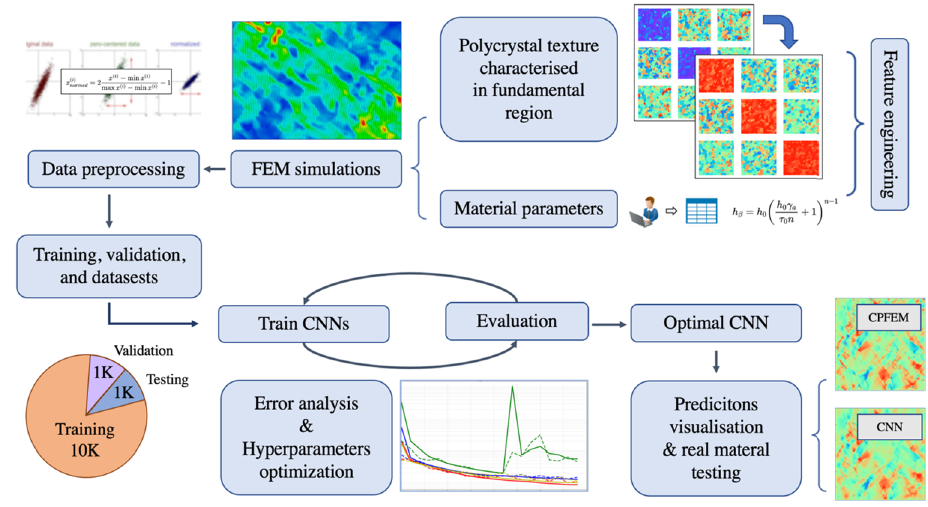
Figure 37. A schematic description of the novel framework proposed by Ibragimova et al. [452] to predict the FLDs of AZ31 and ZE10 Mg sheets. Reprinted from Ref. [452] with permission. Copyright 2022, Elsevier.